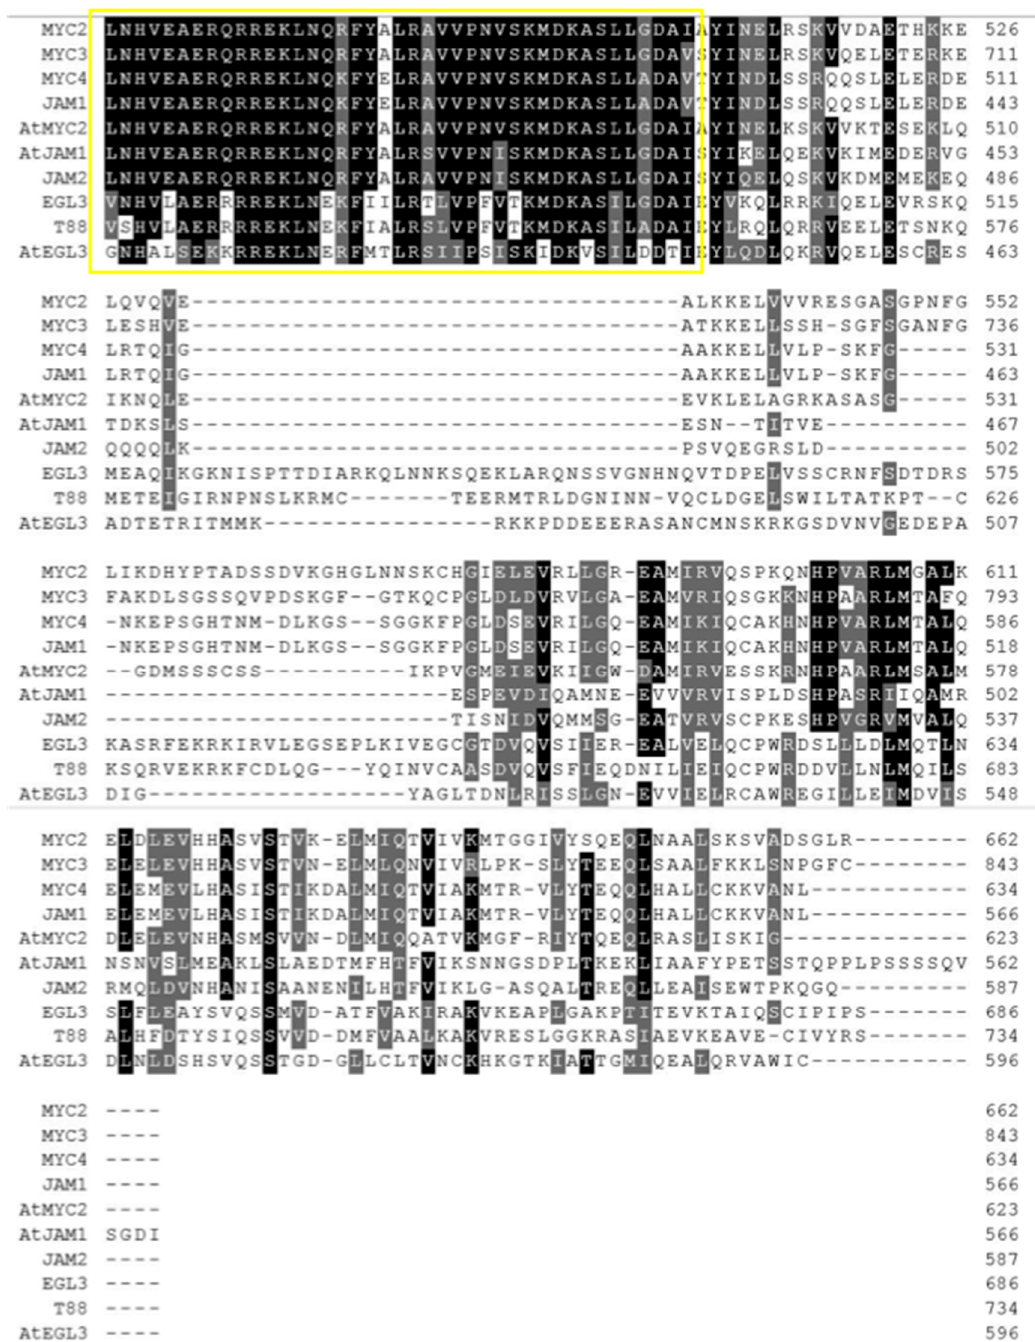
Figure A3. Sequence alignment and domain analysis of MYC transcription factors in Taxus . The red box indicates the JAZ binding region, the green box indicates the transcriptional activation region that binds to MED25, the blue box indicates the DNA binding region, and the yellow box indicates the region that binds to the bHLH class transcription factor.